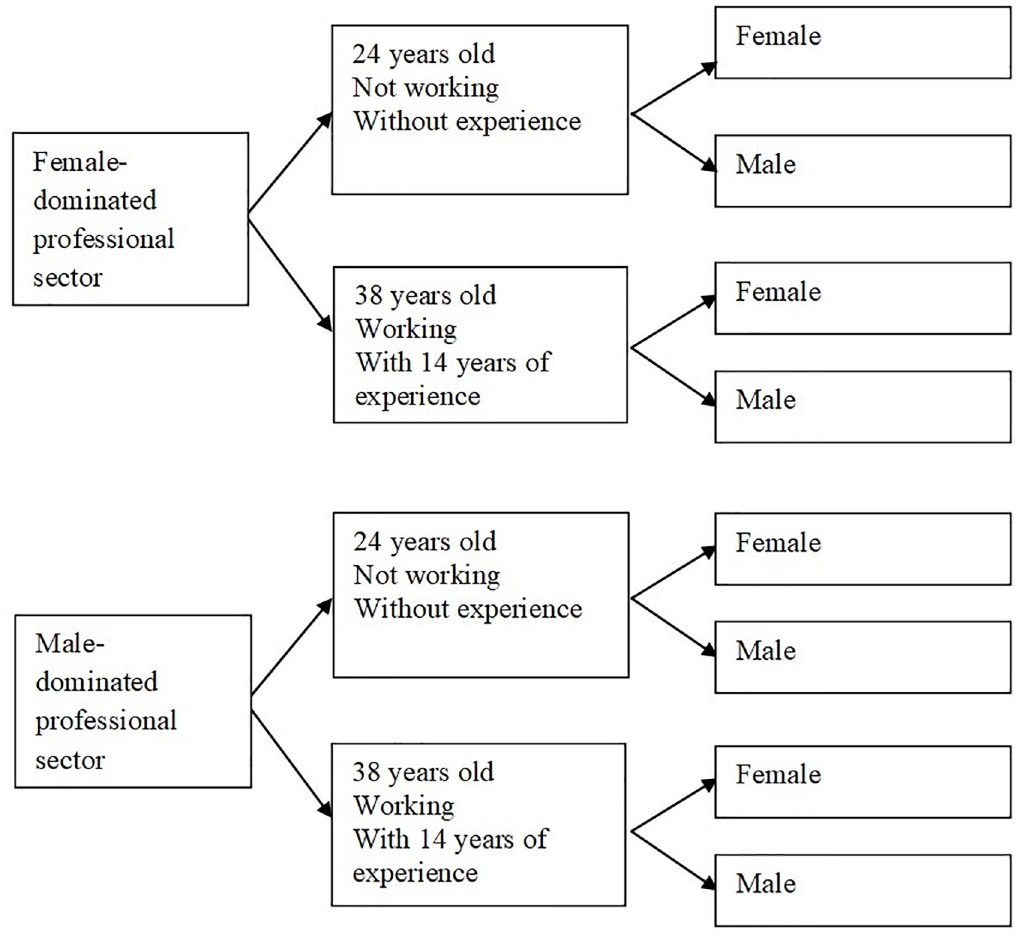
Fig 1. Design summary of the experiment: Eight resumes were matched-paired and submitted to the InfoJobs